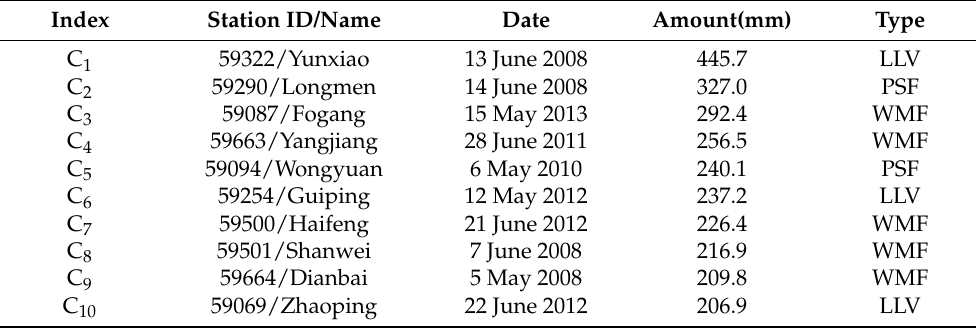
Figure 2. Horizontal distribution of the mean daily precipitation amount composite (shaded, mm) from the 58 WSHR events over South China during the pre-summer months of 2008–2014. Symbols, “C 1 ”–“C 10 ”, denote the top 10 daily rainfall maxima, which are also listed in Table 2. Table 2. The locations (and station numbers), dates (day/month/year), amounts (mm), and classi- fied weather types of the top ten daily-averaged WSHR events during the pre-summer months of 2008–2014 (also see Figure